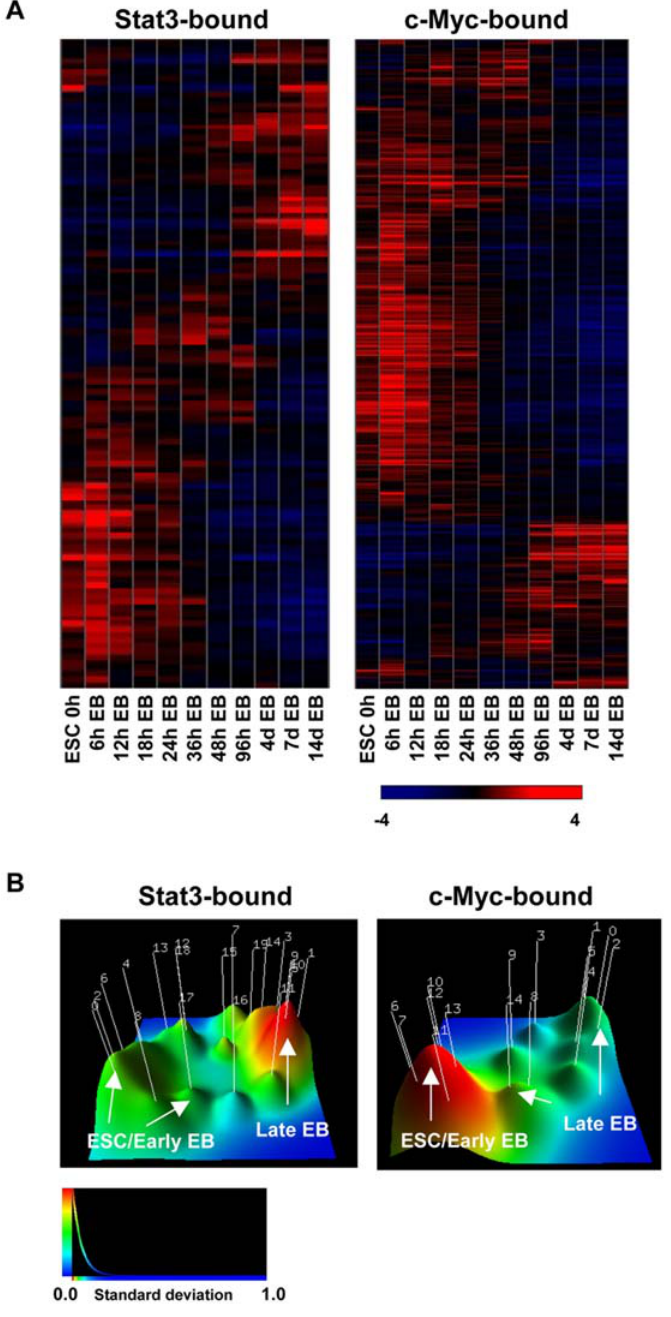
Figure 4. Expression analysis of Stat3 and c-Myc bound genes in ES cells and EBs. (A) Expression analysis of Stat3 and c-Myc target genes in ES cells and differentiated EBs through 14 days. Differentially expressed genes (FDR less than 5%) were compared with Stat3 and c-Myc target genes. (B) Stat3 targets are both active and inactive in ES cells while c-Myc targets are mostly active in ES cells. Three dimensional terrain map of Stat3 and c-Myc target gene expression in ES cells and EBs generated using gCLUTO [28]. Stat3 bound targets are expressed in both undifferentiated ES cells and EB, while more c-Myc targets are expressed higher in undifferentiated ES cells relative to EBs. Peak height is proportional to cluster internal similarity and peak volume is proportional to the number of features within the cluster. doi:10.1371/journal.pone.0003932.g004 and c-Myc binding and RNA expression in ES cells and EBs we Stat3 bound genes that were differentially expressed between ES generated a terrain map of Stat3 and c-Myc target gene expression cells and differentiated EBs were clustered into two main groups of values using gCLUTO (Figure 4B) [28]. Stat3 and c-Myc similar size, including (1) ES cell and early EB and (2) late EB expression value matrices were clustered into 20 and 10 clusters expression, demonstrating a relatively equal distribution of Stat3 respectively to best represent the data set. Multidimensional target gene expression between ES cells and EBs (Figure 4B). scaling (MDS) identified two main peaks within the Stat3 data set. Conversely, MDS identified one main peak within the c-Myc data